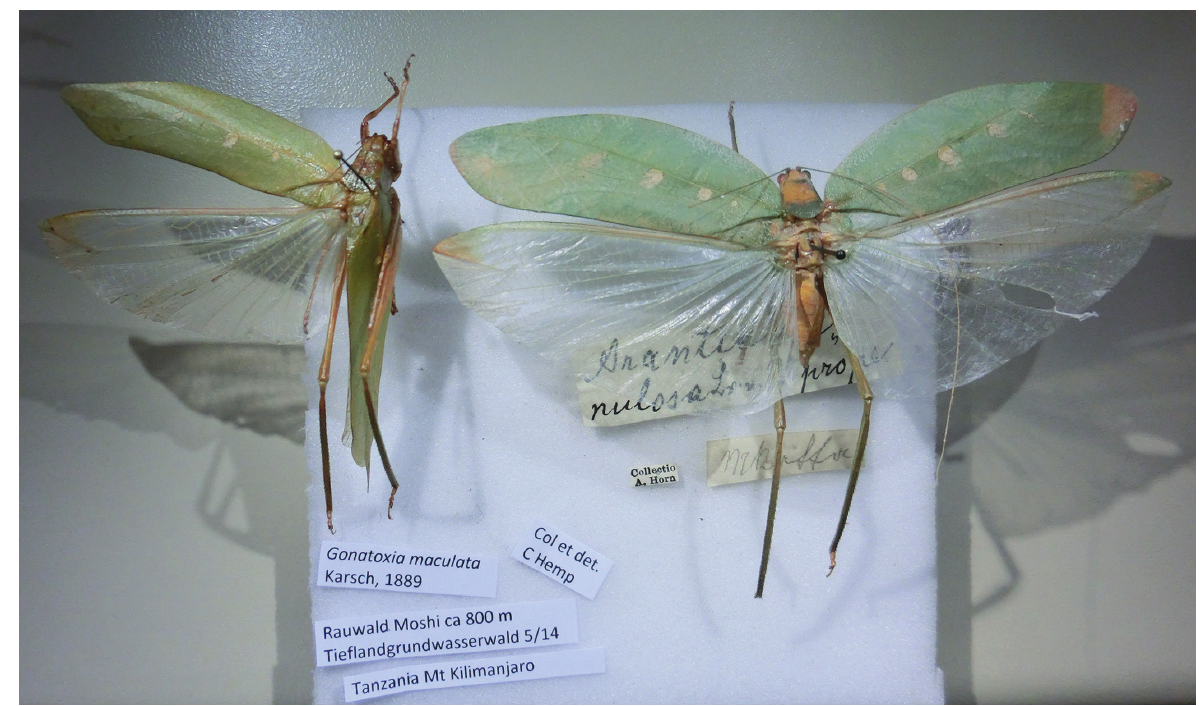
Figure 23. Comparison of G. maculata male from Mt Kilimanjaro with specimen in the collection of Vienna labeled Arantia spinulosa .